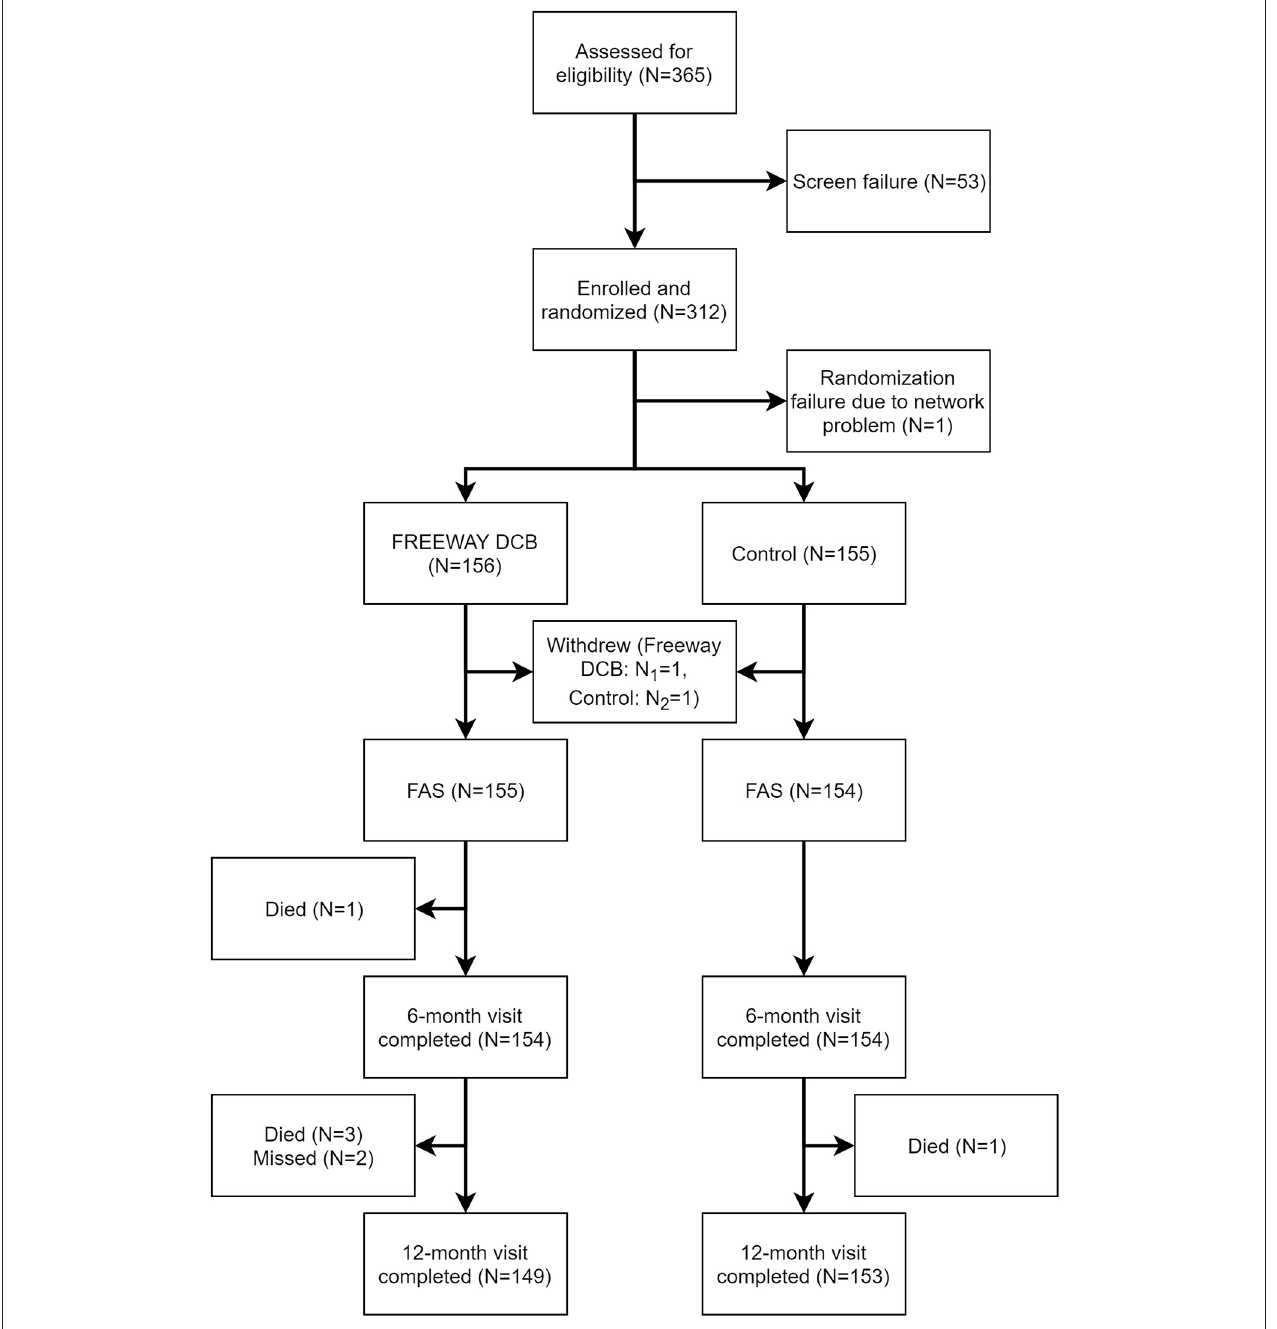
FIGURE 2 | Patient flow in the FREEWAY-CHINA study. FAS, Full analysis set.